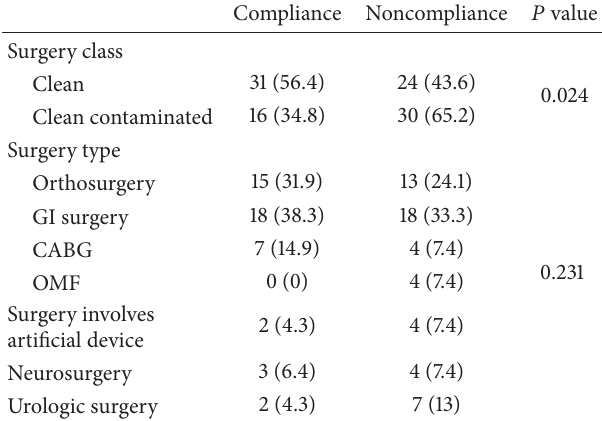
Table 2: Assessment of surgeon adherence to antibiotic prophylaxis guidelines. Figure 2: Types of surgery.